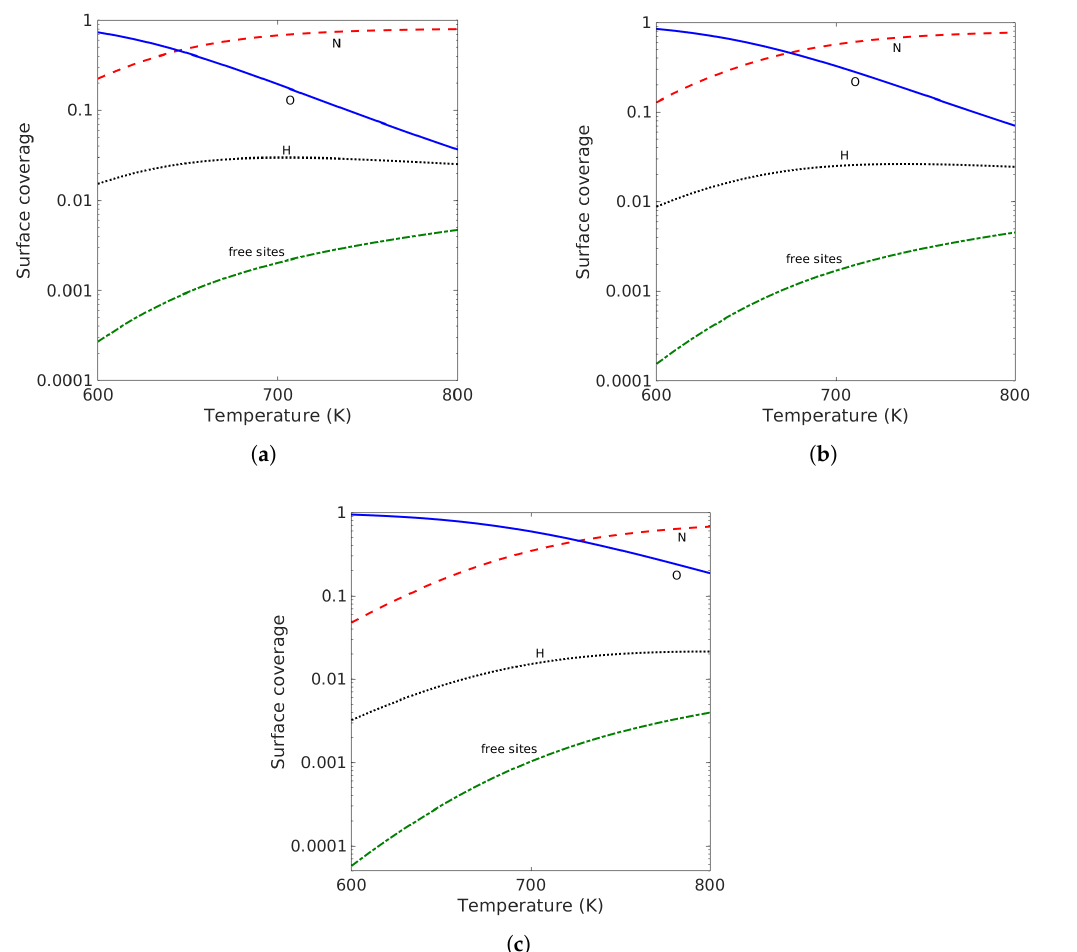
Figure 3. Surface coverage of atomic oxygen, nitrogen, hydrogen and free sites versus temperature. Pressure is 150 bar, H:N = 3:1, y Ar = 0.05 and y NH ( c ) 30 ppm